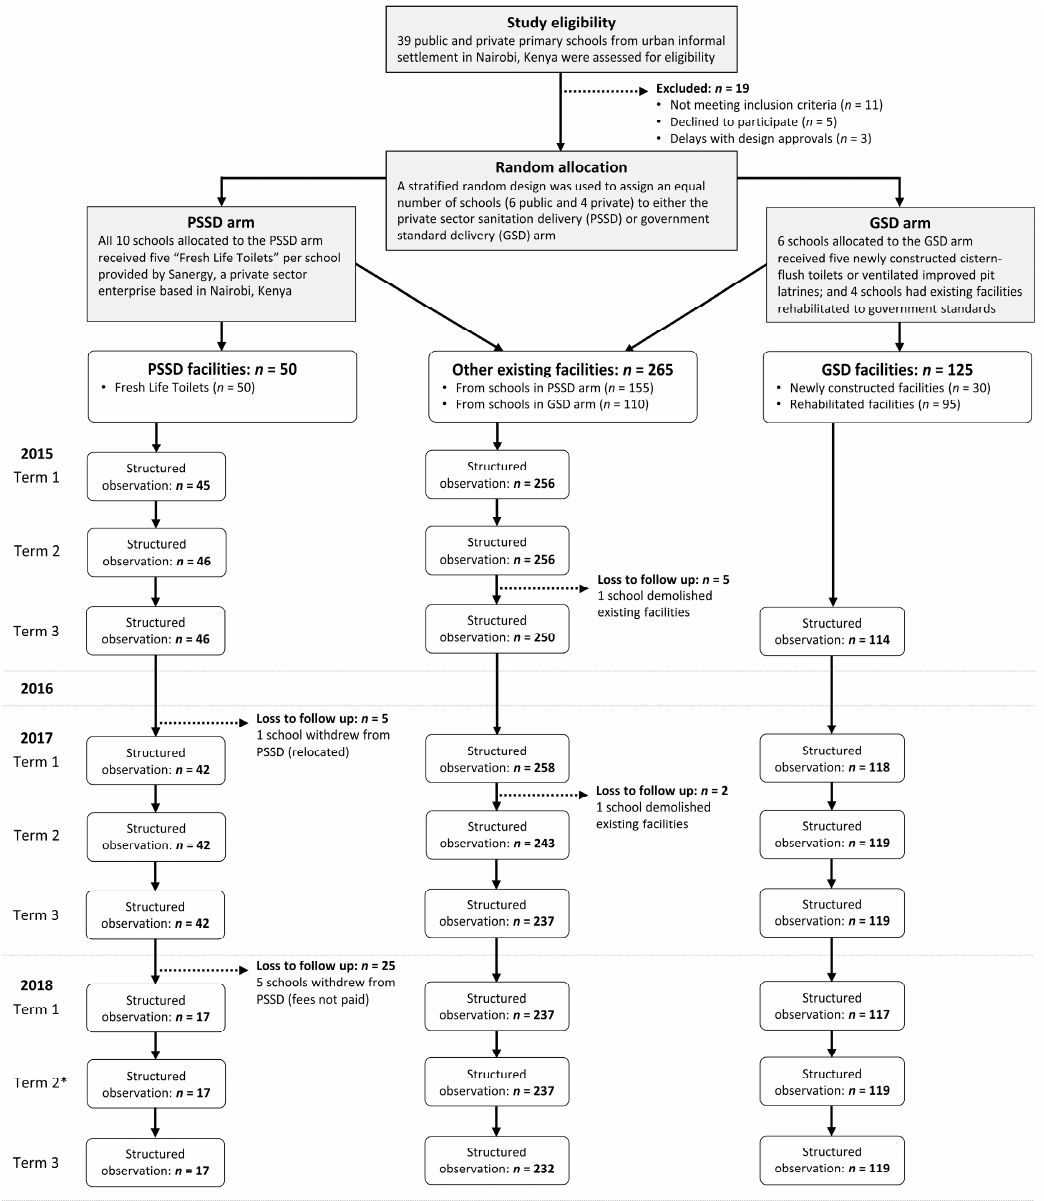
Figure 1. Study flow diagram. * Key informant interviews ( n = 30) from schools in PSSD